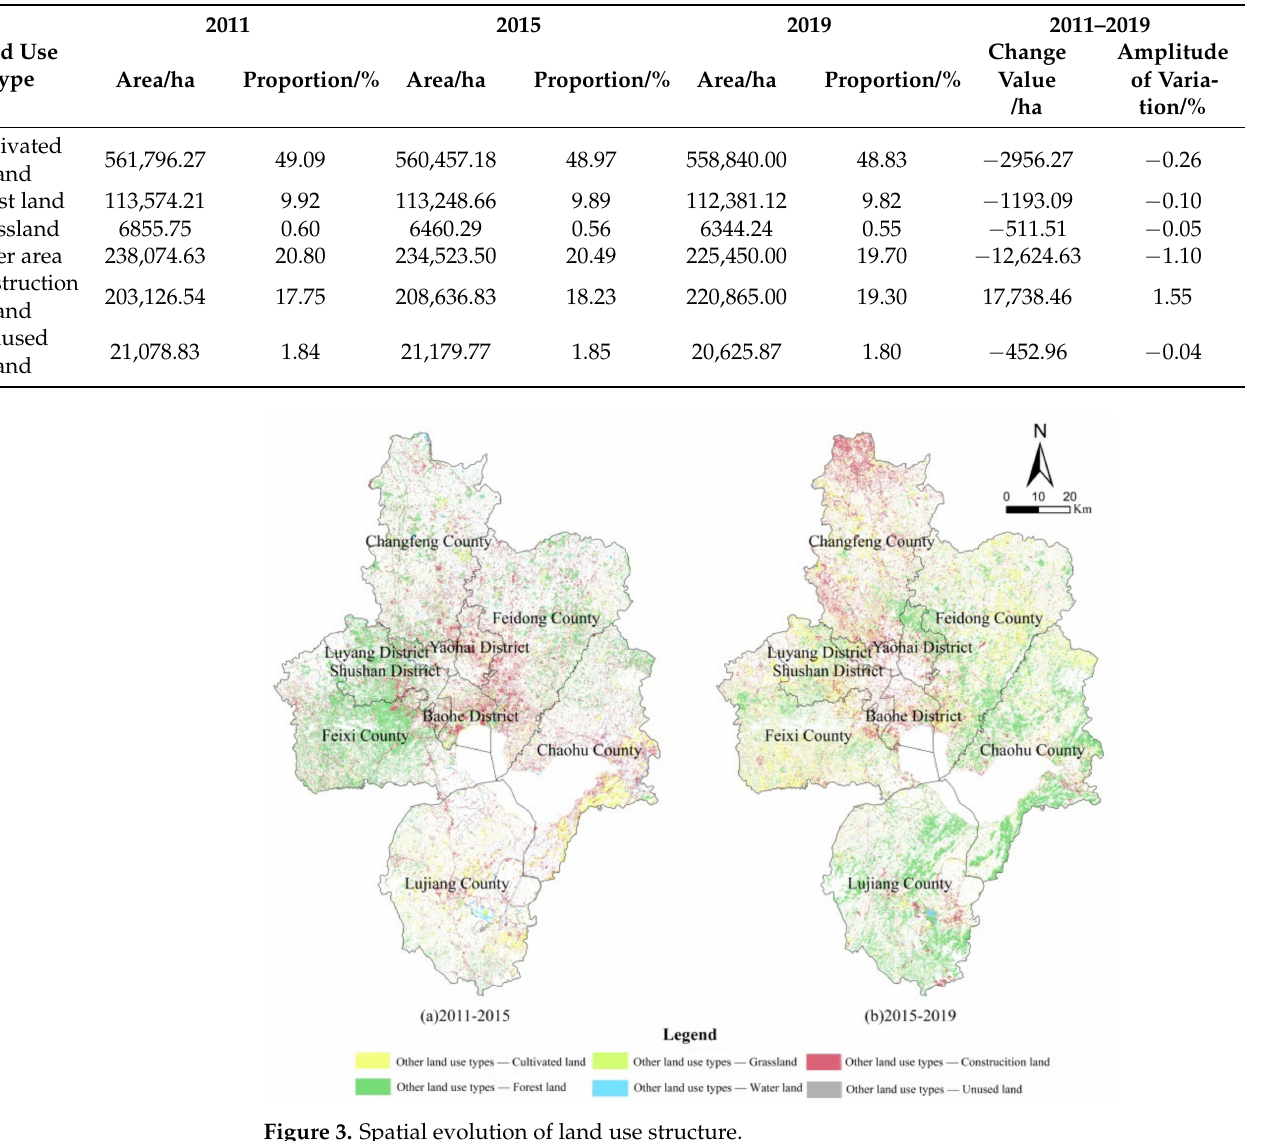
Figure 3. Spatial evolution of land use